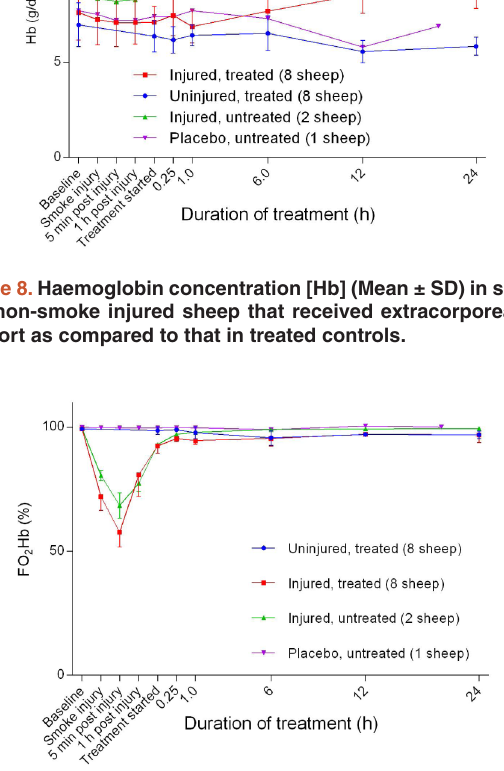
Figure 9. Fraction of oxyhaemoglobin (FO SD) in smoke and non-smoke injured sheep that received extracorporeal life support as compared to that in untreated controls. ) (Mean ± SD with no 2